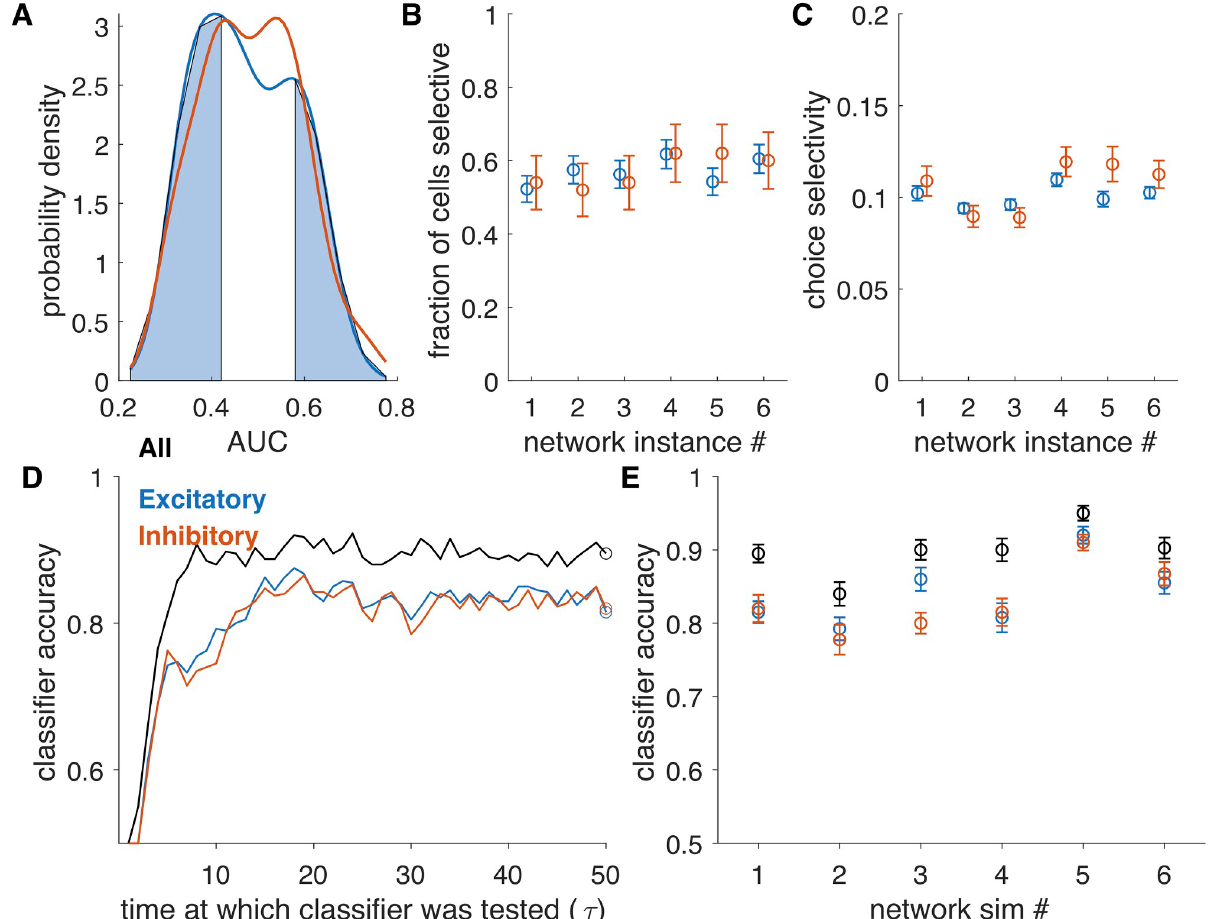
Fig 4. Selectivity and decoding from random network with inputs to excitatory cells only. A. Distribution of AUC values for a single simulation, for excitatory (blue) and inhibitory (red) cells. Shaded regions are those AUC values exceeding significance bounds generated by shuffling trial labels, shown for excitatory cells only. Bounds for inhibitory cells are similar. B. The fraction of cells selective is the fraction of cells in the excitatory or inhibitory populations whose AUC exceeded the significance bounds. The fraction was variable across network realizations, but within each network, it was similar for excitatory and inhibitory cells. Error bars are derived from counting statistics. C. Average choice selectivity (defined as in [1] as the average of | AUC − 0.5|). Averages are over all cells (selective and non-selective) and error bars are SEM. D: Accuracy of a classifier over the course of the stimulus presentation. For each set of cells (all, black; 100 e-cells, blue; 100 i-cells, red), we fit the classifier at a single point in time (circle) and classified activity over the trial. E: Accuracy of classifier across network instances (same order as Fig 2). Error bars are ± 1SE estimated by cross-validation (see